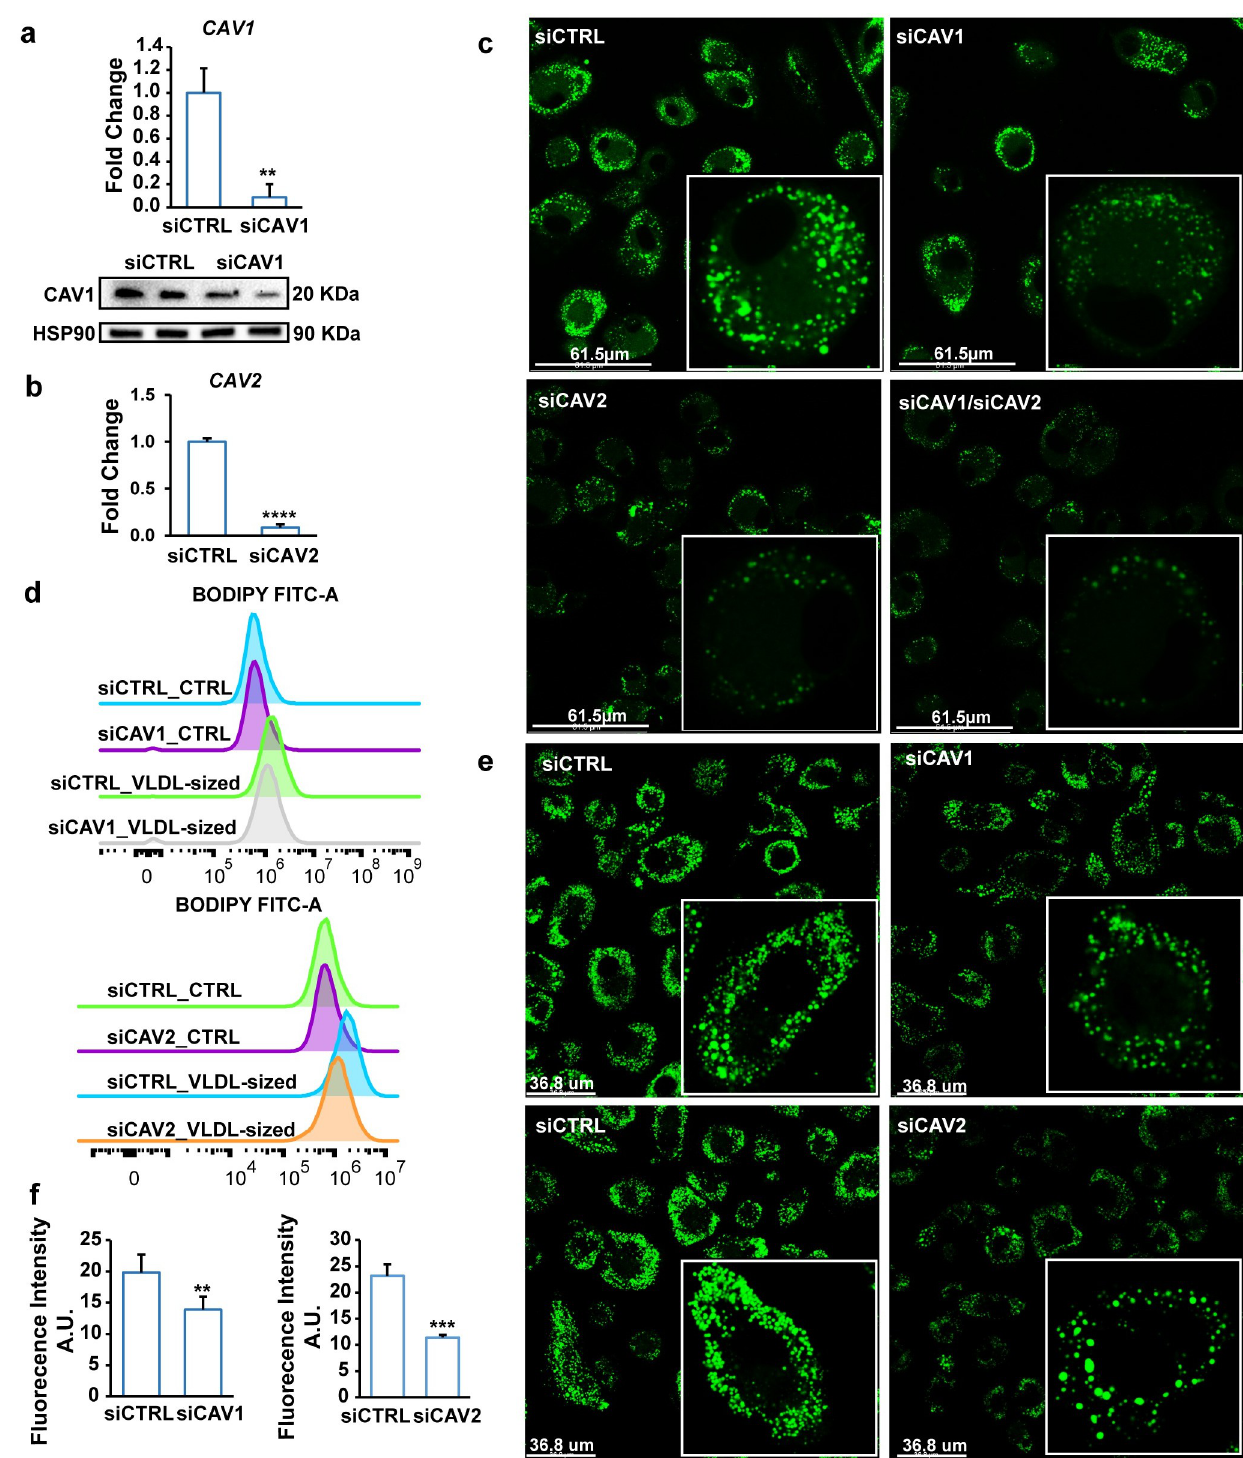
Fig 5. Silencing of Caveolin 1 and 2 impairs uptake of VLDL by macrophages. (a) mRNA and protein levels of Caveolin 1 after 48-hour treatment with siCTRL or siCAV1. (b) mRNA expression of Caveolin 2 after 48-hour treatment with siCTRL or siCAV2. (c) BODIPY 493/503 staining of human macrophages treated with siCTRL, siCAV1, or siCAV2 for 48 hours followed by treatment with 0.5 mM VLDL-sized emulsion particles for 6 hours ( n = 6). (d) Mean fluorescence intensity quantified by flow cytometry ( n = 3). (e) BODIPY 493/503 staining of human macrophages treated with siCTRL, siCAV1, or siCAV2 for 48 hours followed by treatment with 0.5 mM human plasma-isolated VLDL for 6 hours ( n = 6). (f) Mean fluorescence intensity quantified